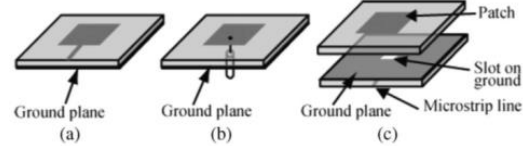
* Corresponding author. Email: